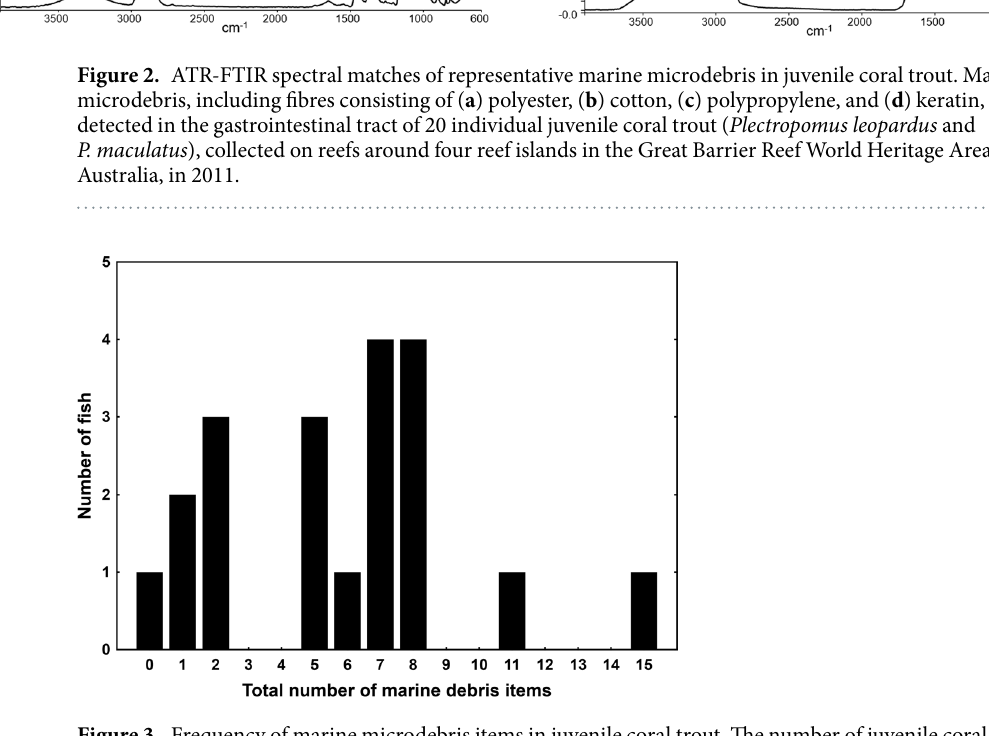
Figure 3. Frequency of marine microdebris items in juvenile coral trout. The number of juvenile coral trout ( Plectropomus leopardus and P. maculatus ) against the total number of marine microdebris items detected in the 20 individual gastrointestinal tracts. Fish were collected on reefs around four reef islands in the Great Barrier Reef World Heritage Area, Australia, in